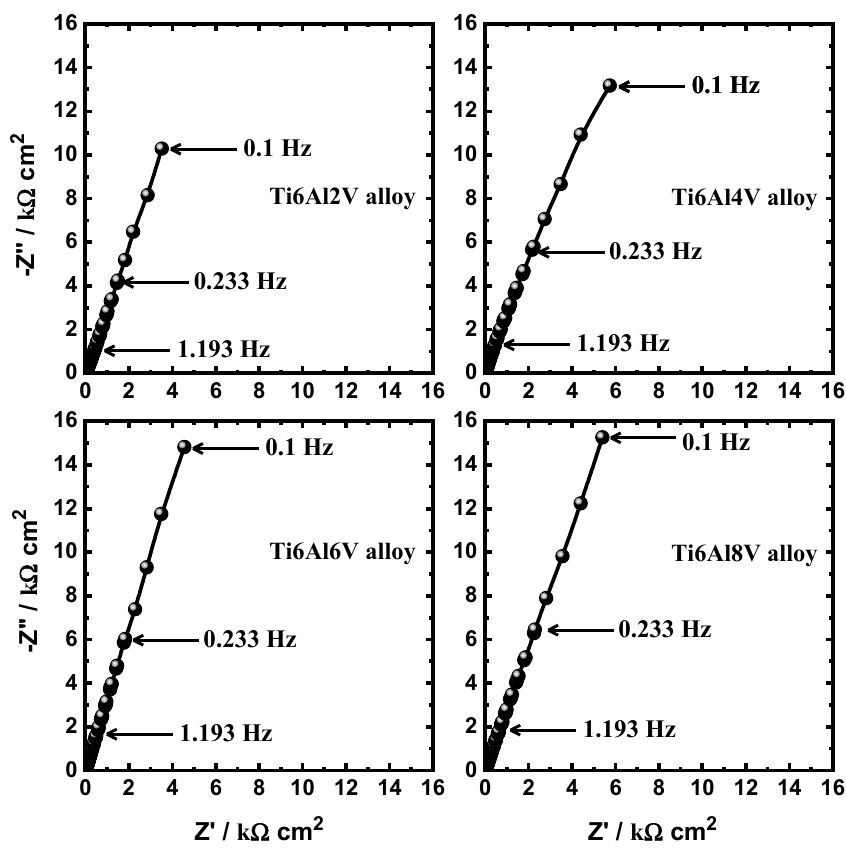
Figure 3. Nyquist plots measured for the different TiAlV alloys after 48 h exposure to NaCl solutions.